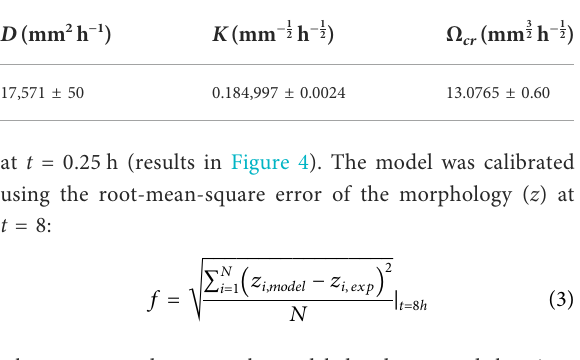
TABLE 2 Calibrated parameters (±95% con fi dence interval) for the